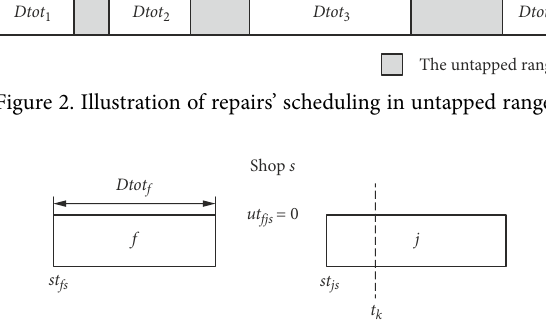
Figure 3. Illustration of untapped range duration